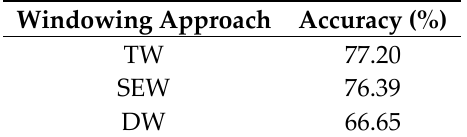
Table 3. Accuracy of each of the windowing